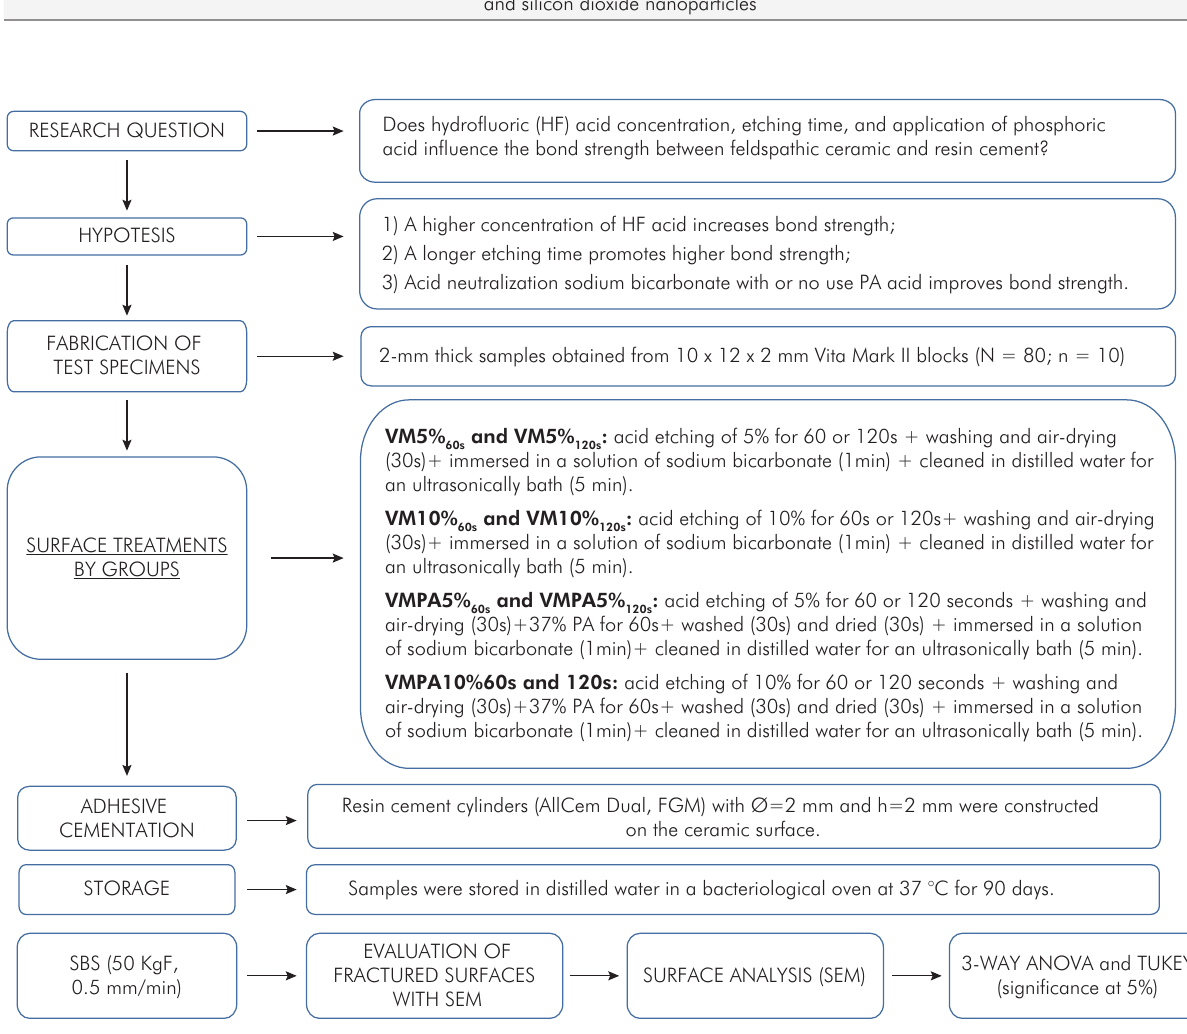
Figure 1. Study flowchart with experimental groups according to the factors: “Phosphoric acid - PA” - 2 degrees: (with acid: PA and without acid) and “HF concentration” (2 degrees: 5% and 10%) and “Exposure time”: (2 levels: HF60s; HF120s) and general information of the methodology. VM: VITA MARK II CERAMIC BLOCKS. * n = 80 and n =